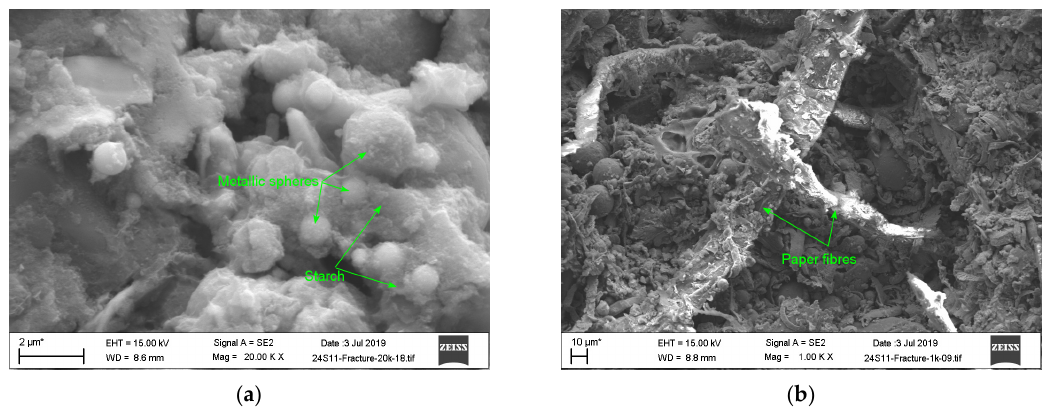
Figure 20. Fracture surface of produced briquettes using starch as binder ( a , b ).